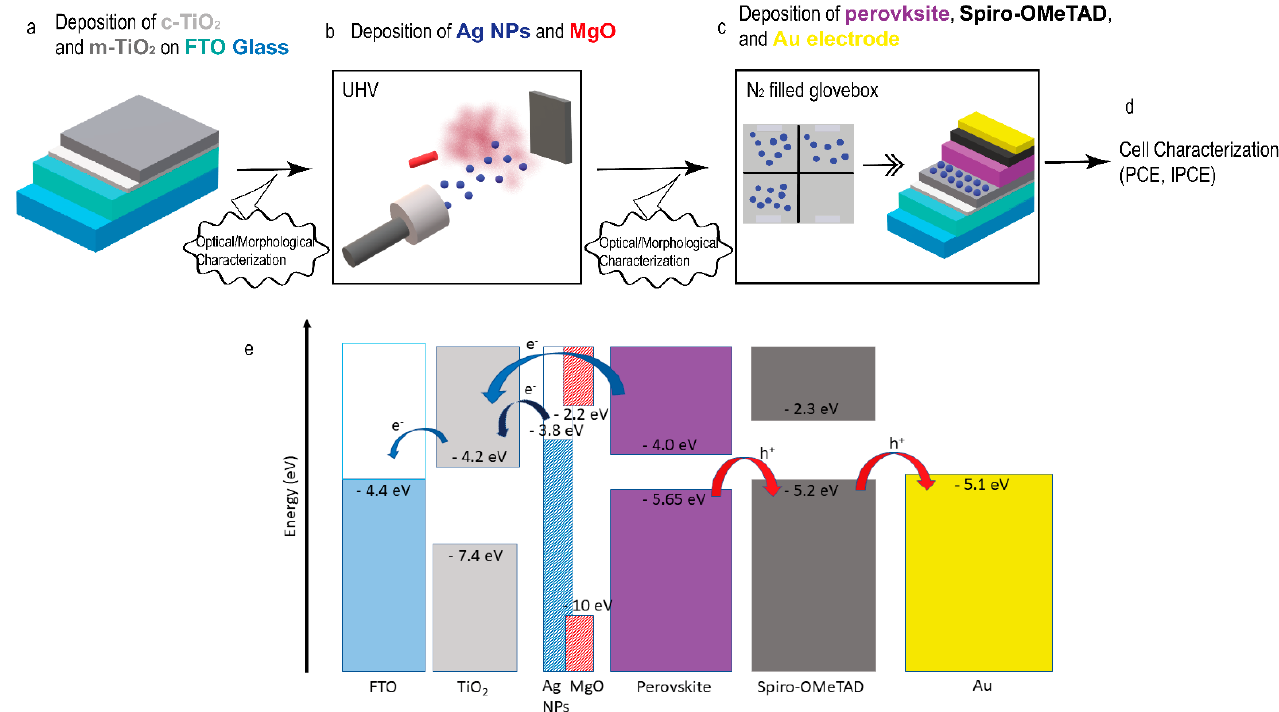
Figure 1. ( a ) Representation of the initial substrate, from bottom to the top: conductive glass substrate (blue) (2.2 mm) covered with an FTO layer (aquamarine) (around 700 nm), compact TiO 2 layer (light gray) (around 50 nm), mesoporous TiO 2 layer (gray) (around 150 nm). ( b ) Scheme of the NP (dark blue) synthesis and deposition with MgO (red) on top of the previously realized m ‐ TiO 2 layer. ( c ) Top view scheme of the experimental device until the m ‐ TiO 2 layer (see the left part of scheme c), containing four independent cells, three of them with NPs and one used as the reference cell, while the right part of scheme c represents the addition of the perovskite layer (violet) (around 400 nm), Spiro ‐ OMeTAD layer (black) (250 nm) and gold layer (yellow) (around 100 nm); NPs are localized at the interface between the perovskite and mesopo ‐ rous TiO 2 layer. The dimensions of each layer displayed here are not to scale. ( d ) Final step of characterization of the engineered solar devices. ( e ) Energy band diagram of the device. The work function values for FTO, TiO 2 have been taken from references [66,67]. The highest occupied molecular orbital (HOMO) and lowest unoccupied molecular orbital (LUMO) levels for perovskite have been taken from reference [68]. The energy band edge positions for Spiro ‐ OMeTAD have been taken from reference [69]. The energy band values for Ag NPs and MgO are taken from reference [70] and [71], respectively. The depicted energy values are relative to the vacuum level. Blue and red arrows show the direction of electron and hole motion, respectively.